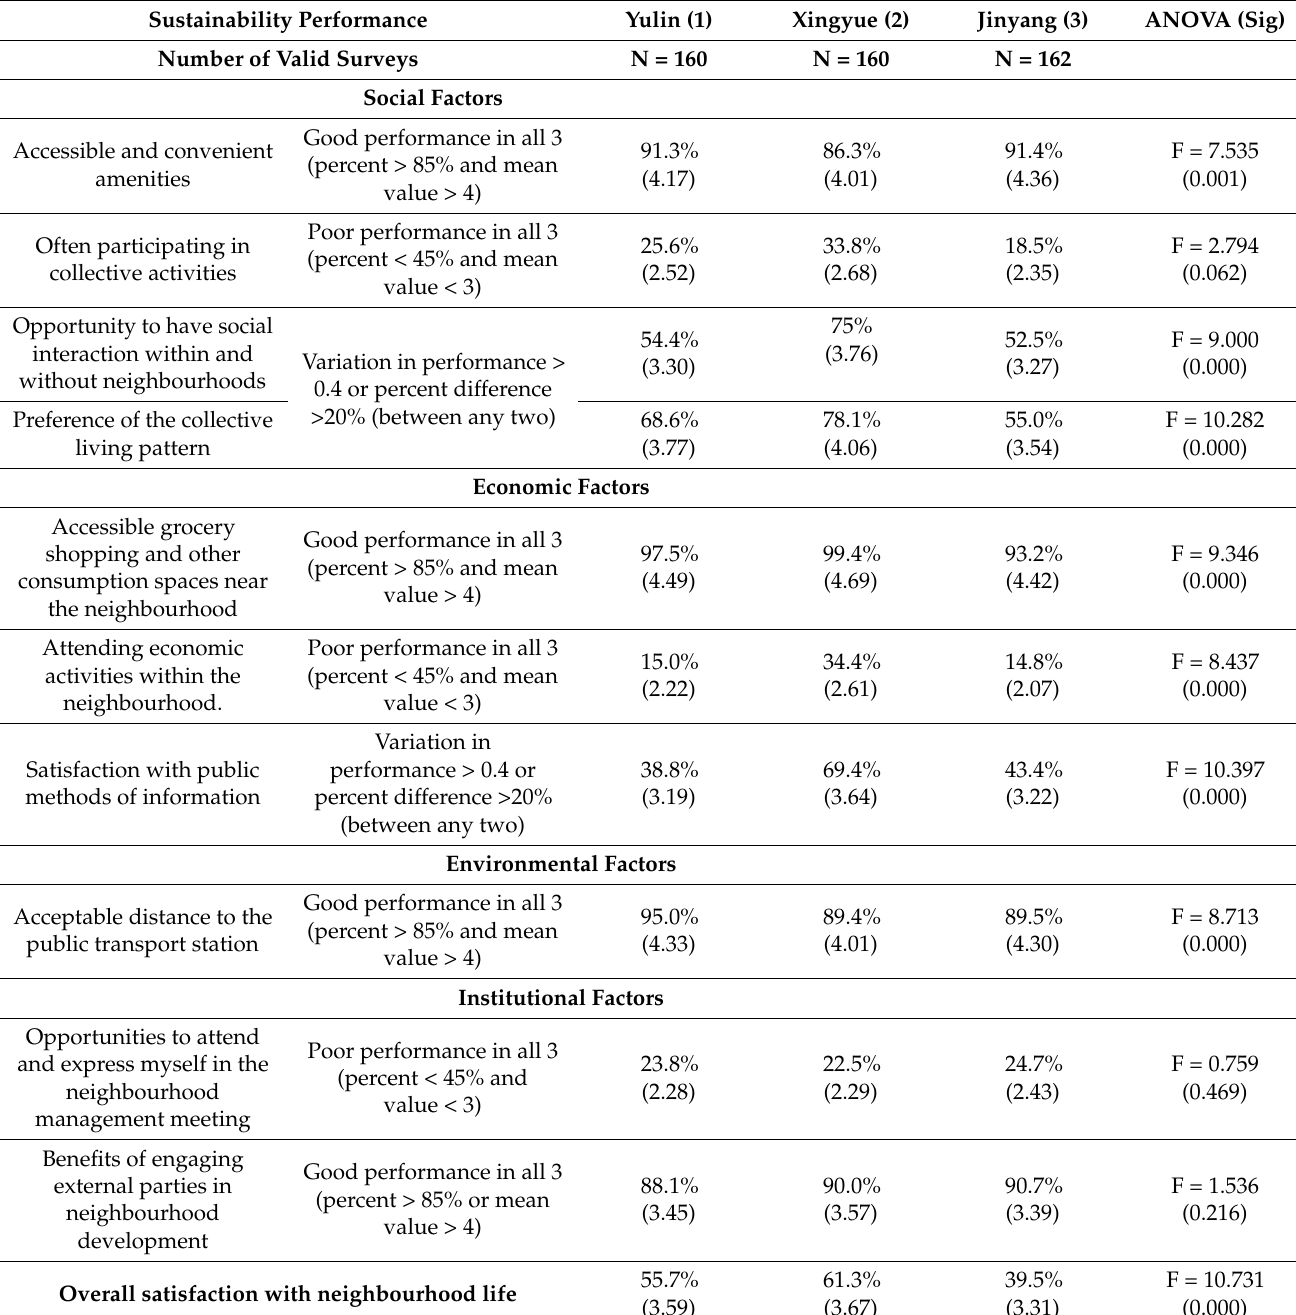
Table 3. Satisfaction rates of the respondents for different sustainability factors in each